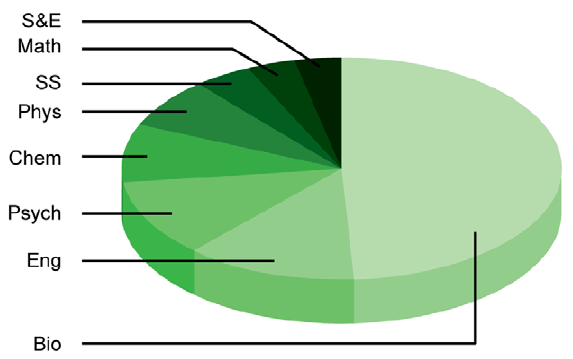
Figure 5. Science and Engineering Postdoctoral Fellows, by Field in 2005. Biological sciences (lightest shade) represented the overwhelming majority of postdoctoral fellows in 2005 (49.1%) compared to other sciences. SOURCE: National Science Foundation, Science and Engineering Indicators 2010.